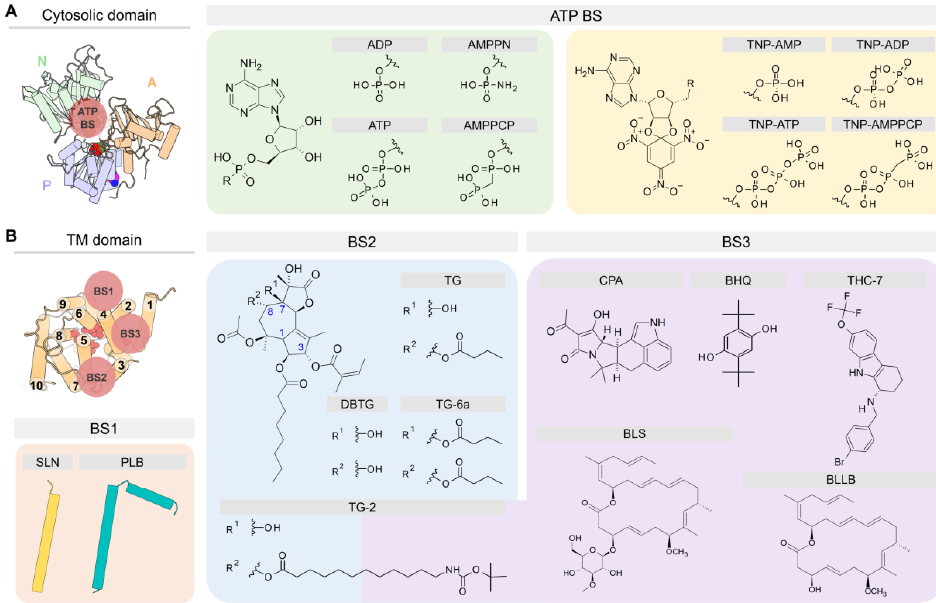
Figure 6. Chemical structures of small molecules cited in the text and schematic representation of their binding sites (BS) in the ( A ) cytosolic domain and ( B ) TM domain of SERCA. binding sites (BS) in the ( A ) cytosolic domain and ( B ) TM domain of